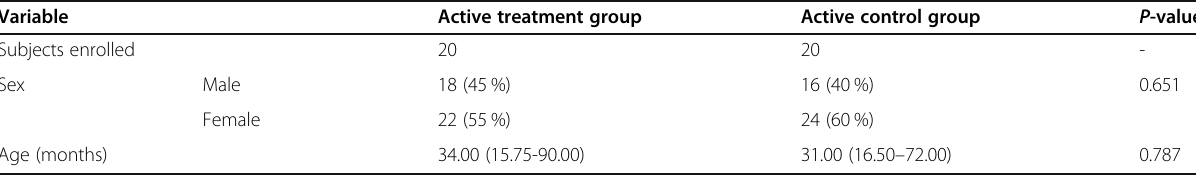
Table 1 Demographic data between two groups of case and control Variable